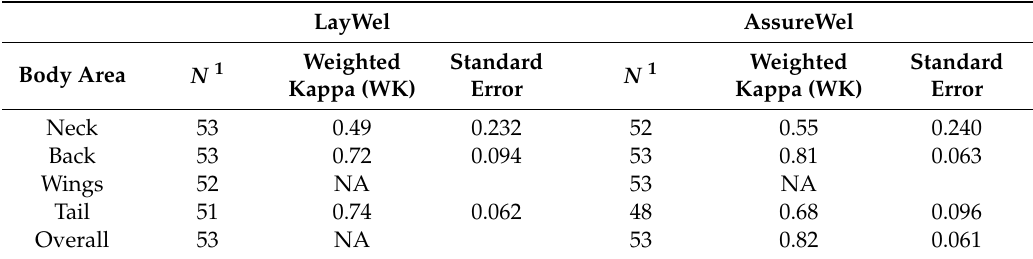
Table 2. Intra-observer reliability of feather damage (FD) scoring in laying hens based on two existing scoring systems using numeric scales (LayWel, 1–4 scale and AssureWel, 0–2 scale). Di ff erent body areas were assessed, and one overall score was given based on the overall impression of the hen. Reliability was assessed as weighted kappa (WK). Not applicable (NA) indicates cases where WK could not be calculated due to the fact that not all the same score categories were used. LayWel AssureWel